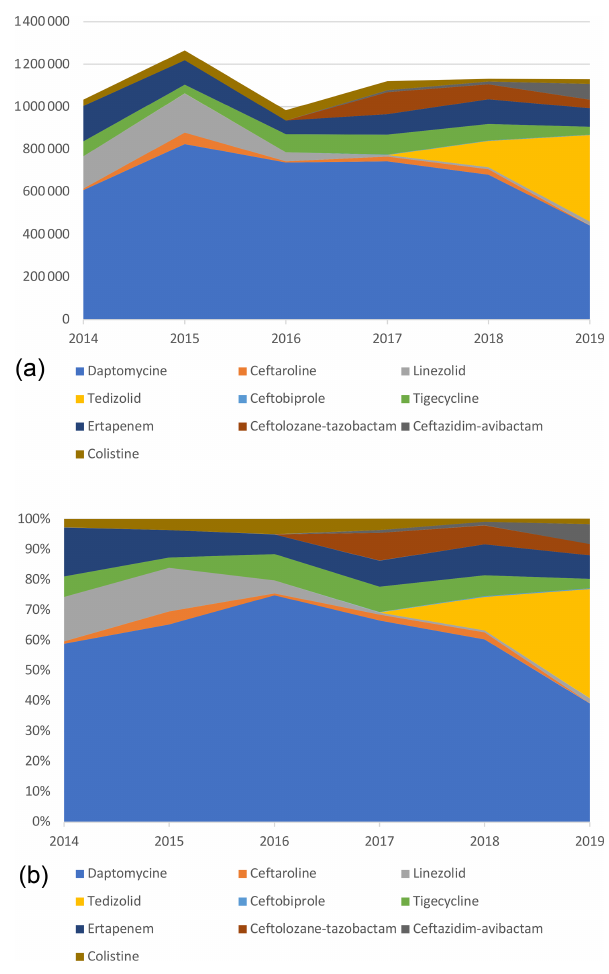
Figure 3. Cumulative (a) and proportional (b) costs (EUR) related to expensive treatments, by